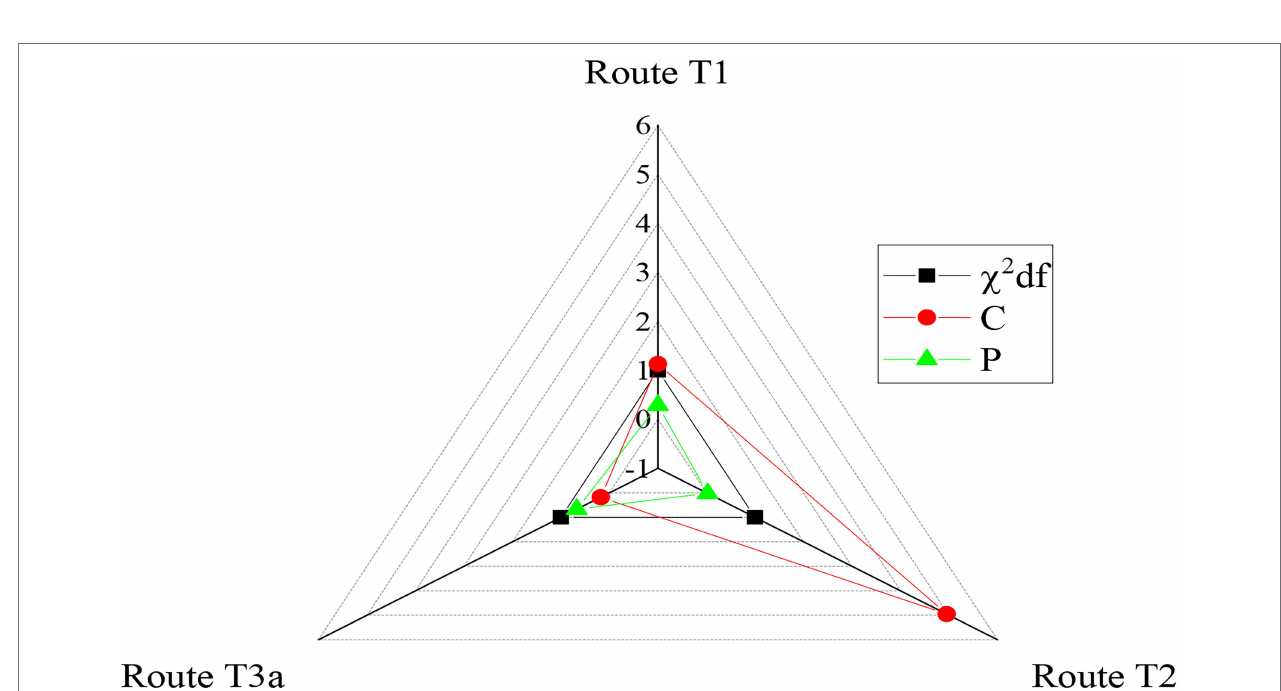
FIGURE 10 | Chi-square